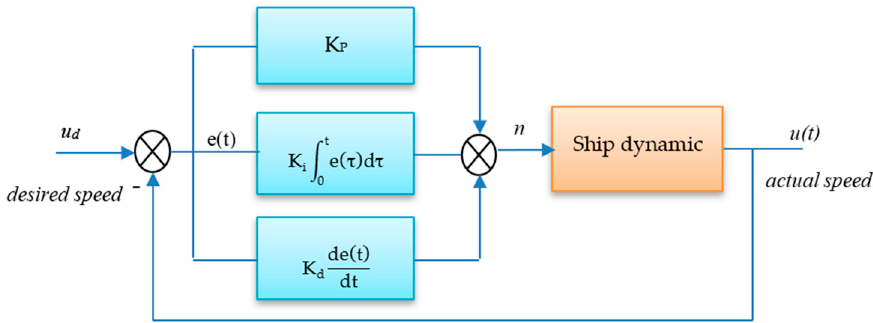
Figure 7. The scheme of ship’s speed control using proportional-integral-derivative (PID) algorithm.